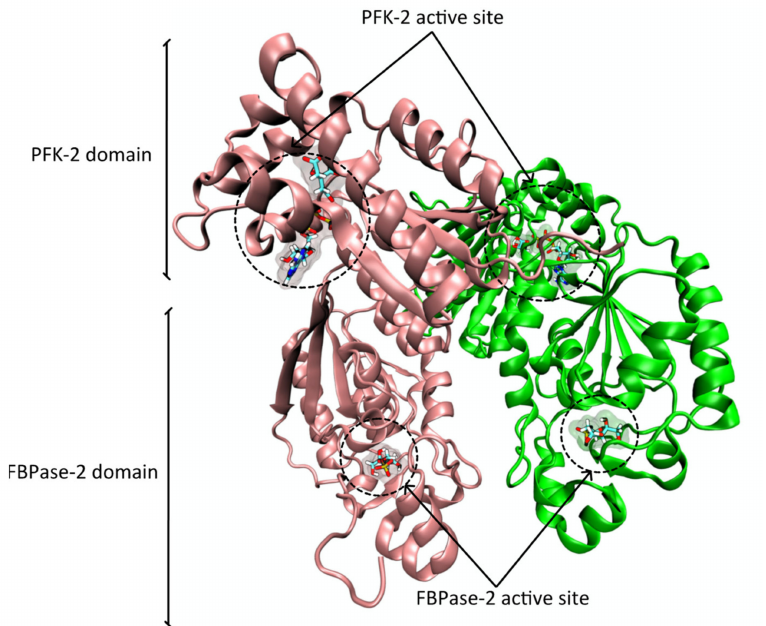
Figure 3. Ribbon representation of the human PFK-2/FBPase-2 (PFKFB2) enzyme with the PDB